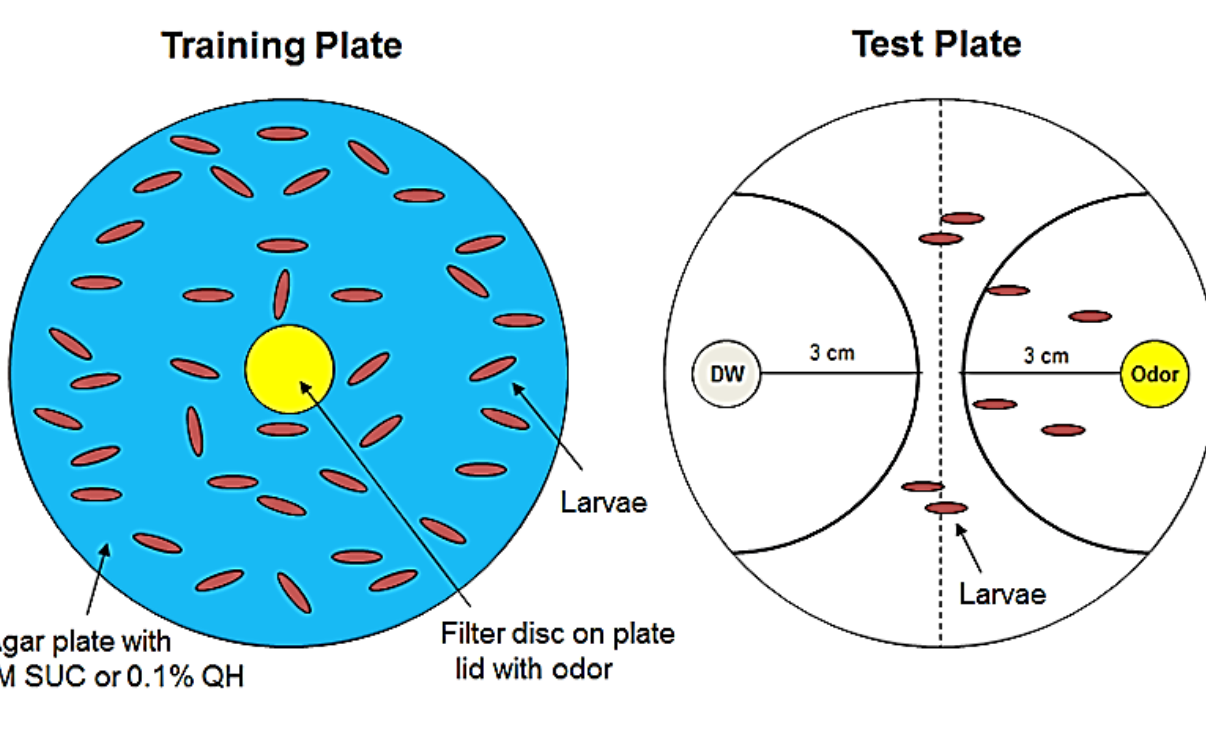
Figure 1. Larval olfactory learning assay. ( Left ) Training: third-instar larvae (92–96 h after egg laying) are trained on a 2.5% agar plate that is covered with 2 mL of either 1 M sucrose solution (SUC, for appetitive learning) or 0.1% quinine hemisulfate solution (QH, for aversive learning). Distilled water (DW) is used as a control. During training time, an odorant (Pentyl Acetate) is placed on a small piece of filter inside the lid. ( Right ) Test: Larvae are rinsed and transferred to the middle line of a new 2.5% agar plate after training. A small piece of filter paper with Pentyl Acetate (PA) is placed on one side of the plate, while the control is the other side. We then counted the number of larvae in the two semicircular areas and calculated the response index (R.I., see text for further detail) after 5